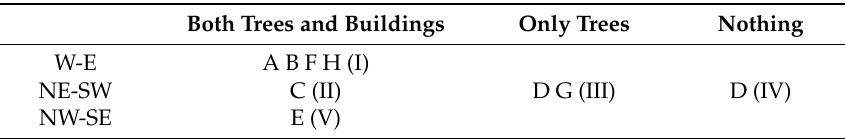
Table 5. Classification by the existence of buildings and street trees that block the Sun based on street direction. Both Trees and